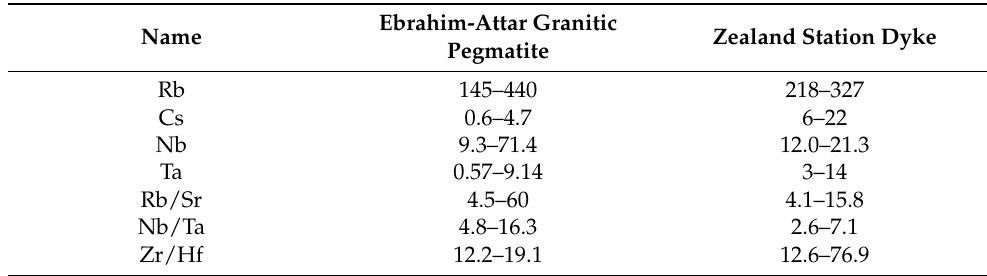
Table 4. Comparison of chemical compositions of the Ebrahim-Attar granitic pegmatite [30] and Zealand station dyke as Be-bearing LCT in Canada